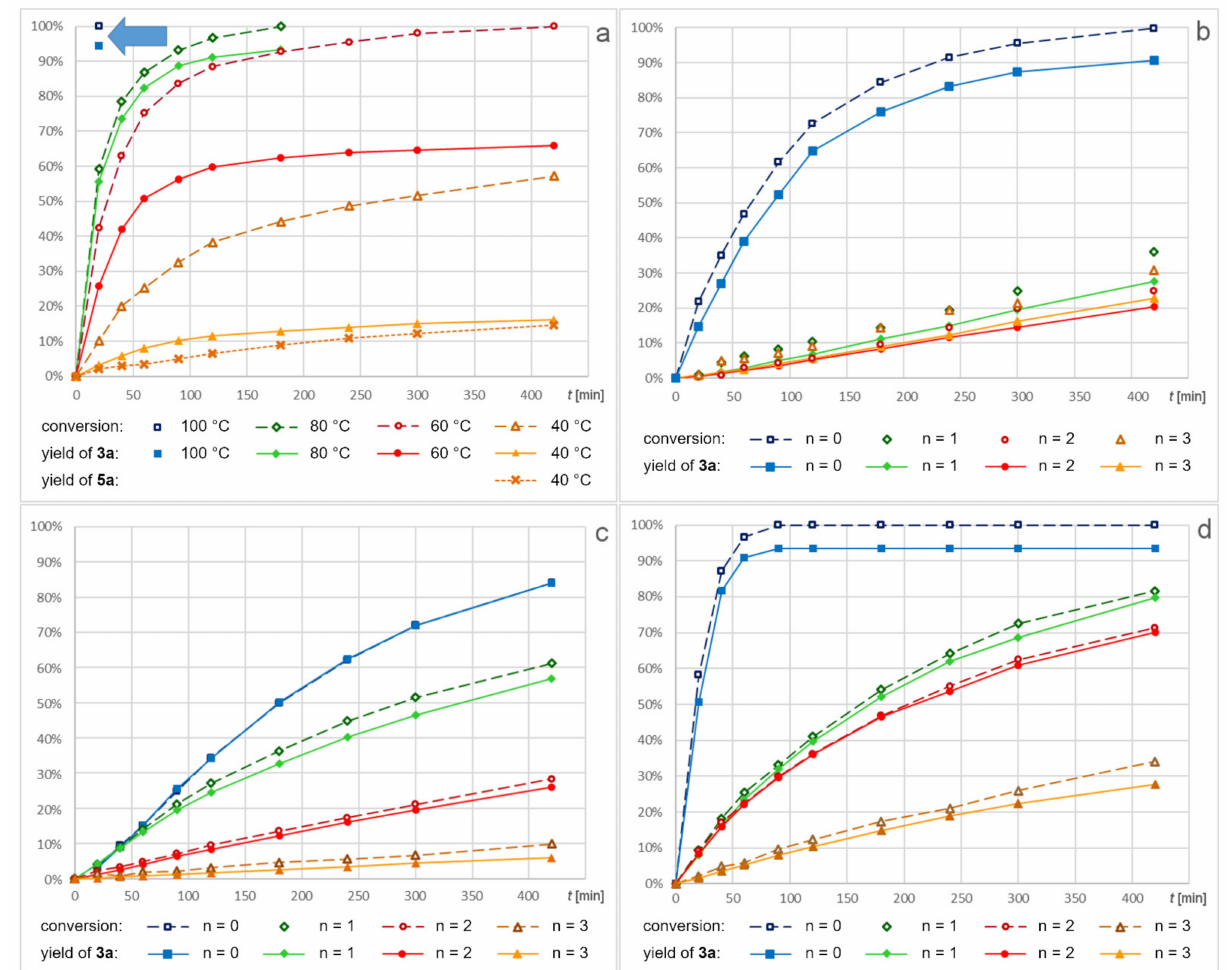
Figure 1. Time course of redox esterification of cinnamaldehyde with benzyl alcohol (4 equiv) in toluene; ( a ) effect of temperature on the reaction catalyzed by G 0 DippImI (10 mol%; DBU 10 mol%); ( b ) 100 ◦ C, influence of the support, precatalyst from methylimidazolium series G n (MeImI) m (n = 0–3, 10/m mol%; DBU 10 mol%); ( c , d ) 100 ◦ C, influence of the support and amount of the base, precatalyst from Dipp imidazolium series G n (DippImI) m (n = 0–3, 1/m mol%; DBU 2 mol% ( c ), 10 mol% ( d